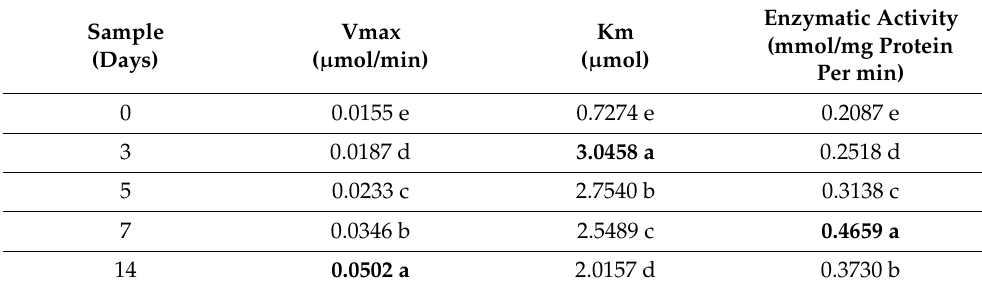
Table 3. Kinetic parameters of the cytochrome P450 enzyme complex in Eisenia fetida exposed for 14 days.